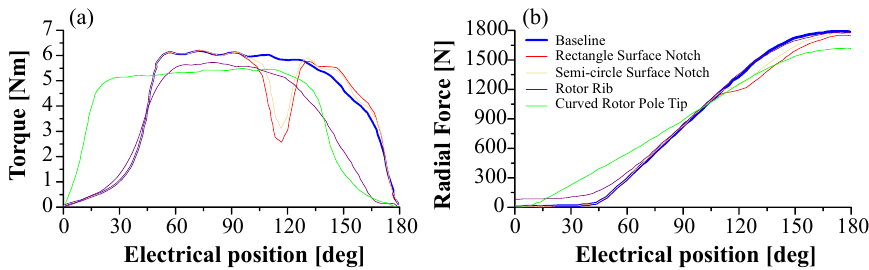
Figure 23. Comparison of motor characteristics for the rotor pole tip modifications: ( a ) static torque and ( b ) static radial